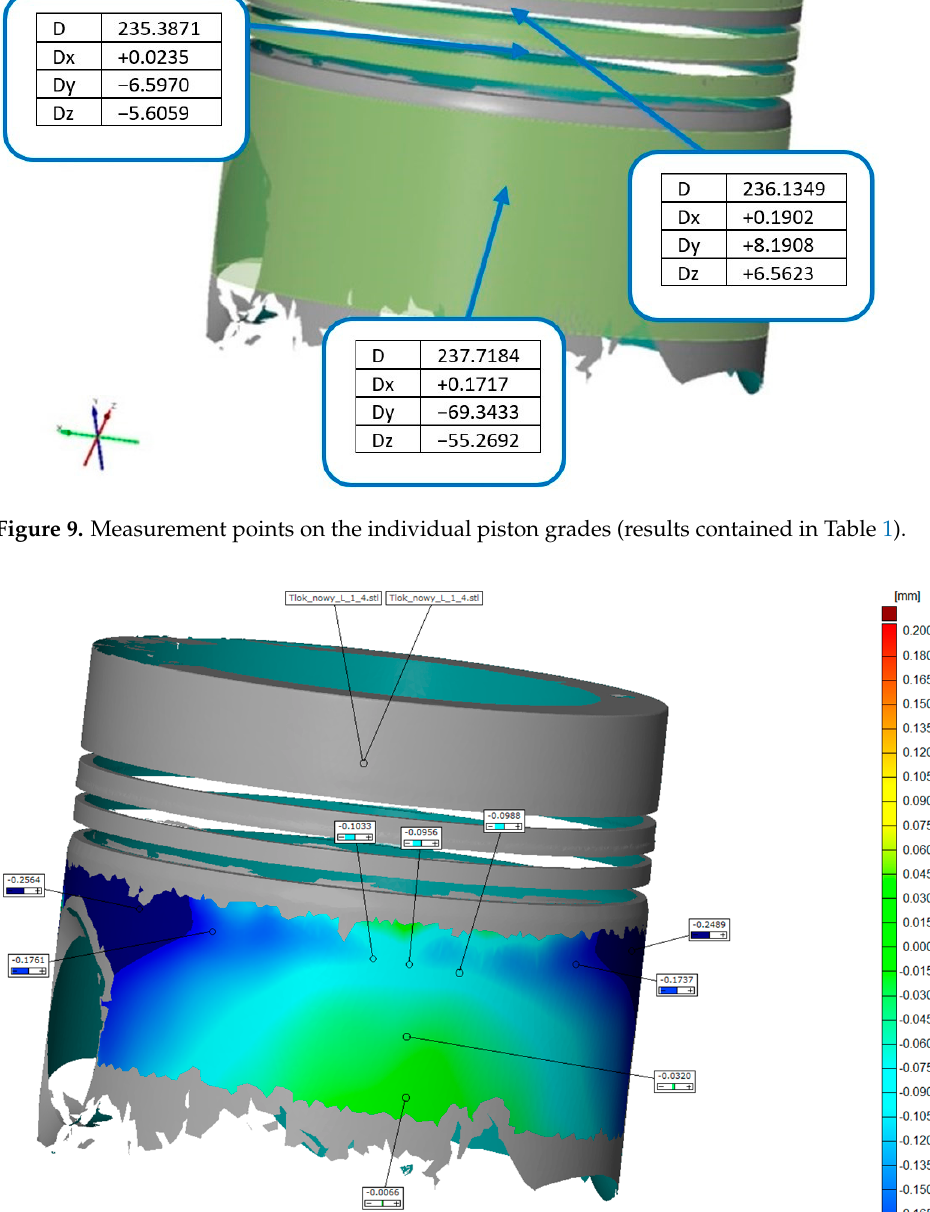
Table 1. The base dimensions correspond to the average values of a new piston. Table 1. Difference in the dimensions at the individual circumferences of the new and the worn pistons.